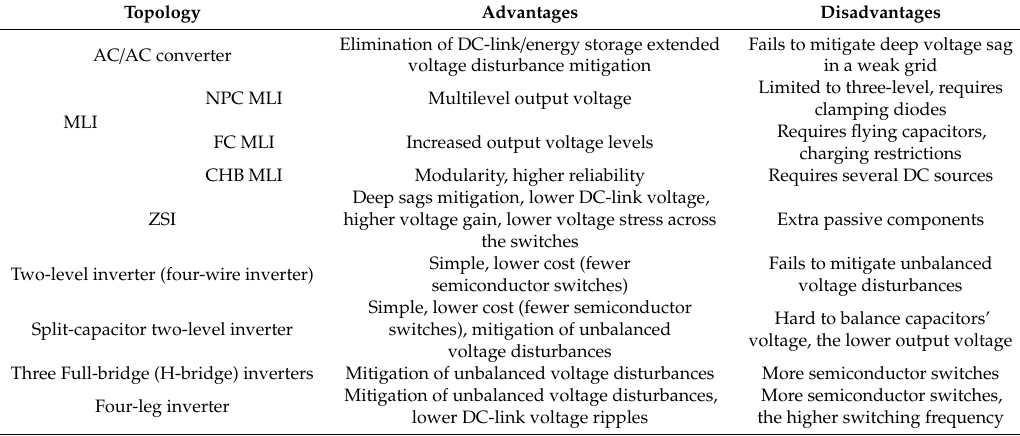
Figure 8. Three-phase power converter topologies of Dynamic Voltage Restorer (DVR) based on ( a ) two-level inverter, ( b ) split-capacitor two-level inverter, ( c ) three full-bridge inverters, and ( d ) impedance-source inverter (ZSI). Based on data from [82 – 93]. Table 6. Three-phase power converter topologies of DVR, advantages, and disadvantages. Based on data from [82 – 93].